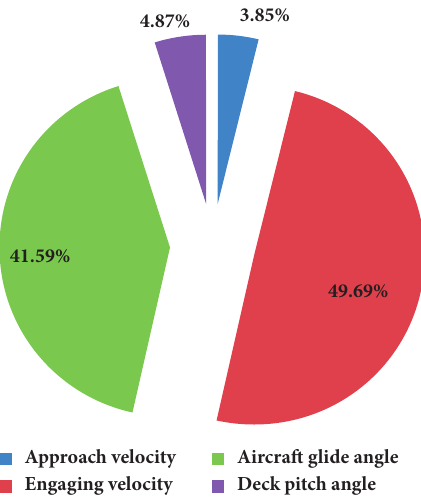
Figure 7: The average influence degree of each correlated parameter on sinking velocity. Table 7: The samples whose influence degree on sinking velocity has a sudden change.